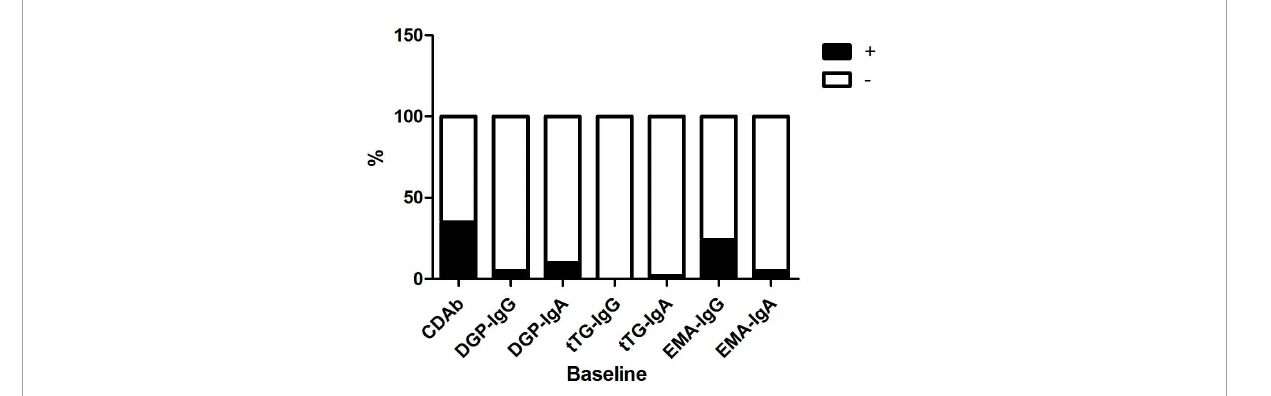
FIGURE1 Distribution of CDAbs in children with T1D. CDAbs, celiac disease autoantibodies; T1D, type 1